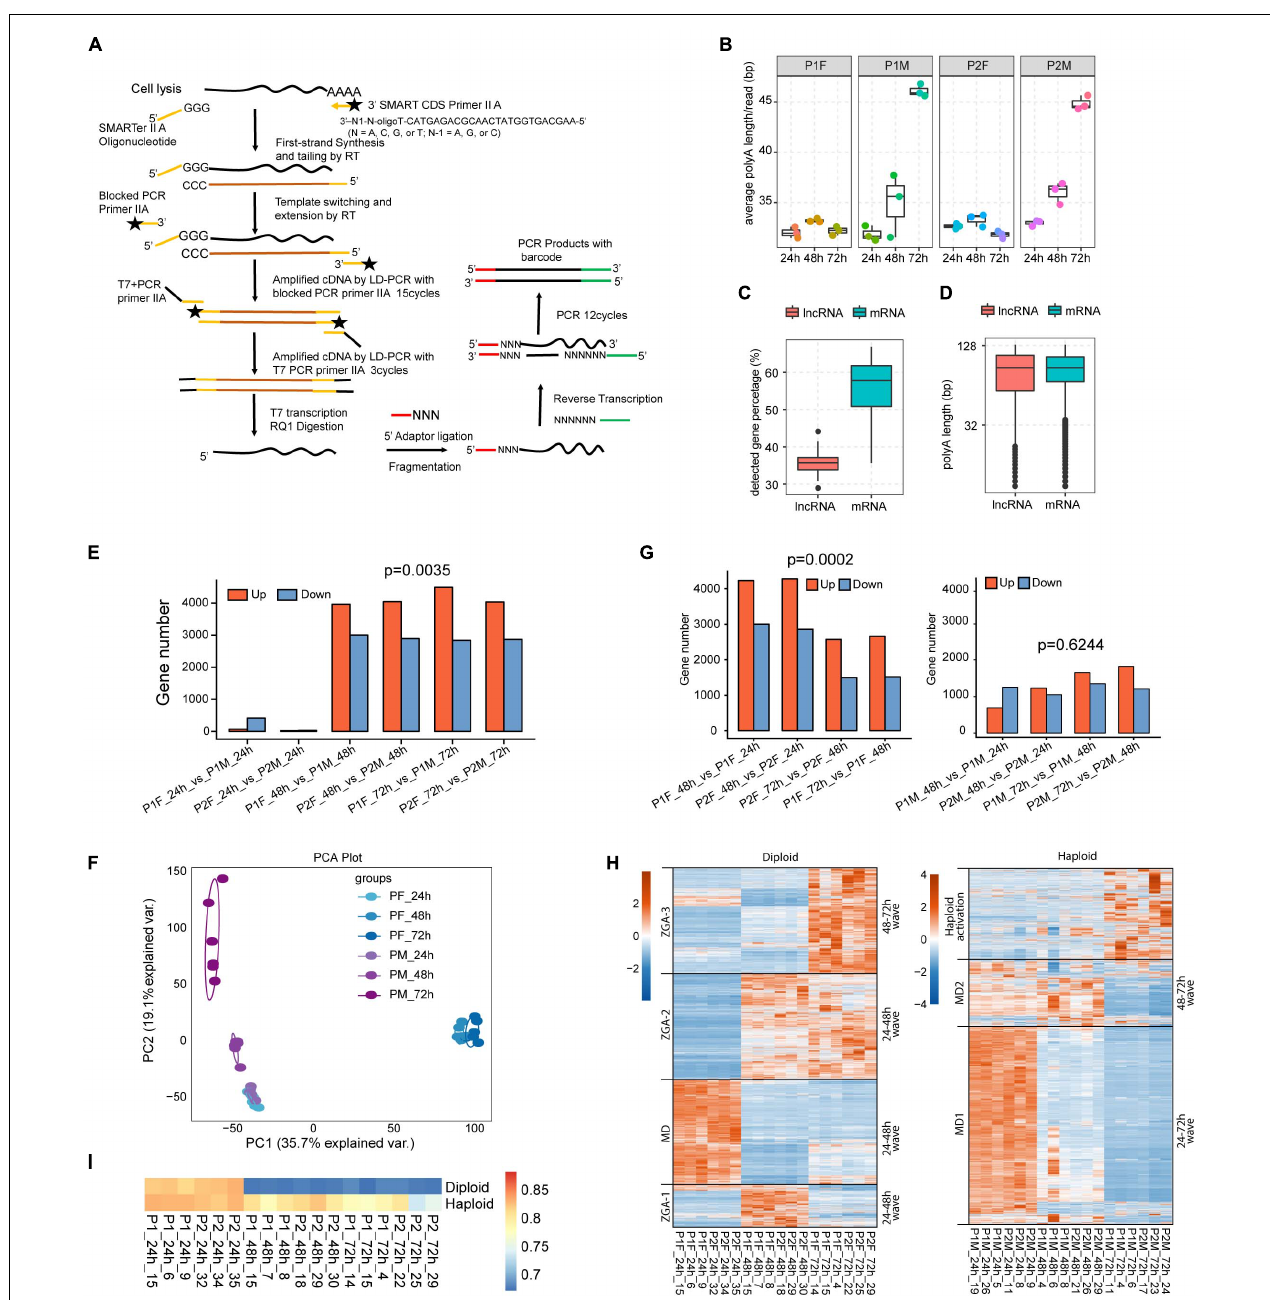
FIGURE 1 | The difference in the developmental transcription program activation between diploid female and haploid male embryos. (A) Schematic plot showing the workflow of single-embryonic library construction. (B) Box plot of average poly (A) length showing that the poly (A) length of male embryos increased during embryonic development ( p -value < 0.001, one way ANOVA test for both datasets), while that of female kept constant ( p -value > 0.01, one way ANOVA test for both datasets). (C) Box plot showing that the percentage of lncRNAs with poly (A) tails was lower than that of mRNAs ( p -value < 0.0001, t -test). (D) Box plot of the poly (A) length showing that there was no significant difference of average poly (A) length (middle line in box plot) between lncRNAs and mRNAs ( p -value > 0.05, t -test). (E) Barplot of DEGs between male and female embryos. More up-regulated DEGs were observed in female embryos after 24 h (up-regulated DEGs number vs. down-regulated DEGs number, p -value = 0.0035, t -test). (F) PCA analysis showing the divergent gene expression pattern between male and female embryos after 24 h. (G) Barplot of DEGs between adjacent time points for female (left) and male (right) embryos, respectively. More up-regulated DEGs were observed in female embryos during development (up-regulated DEGs number vs. down-regulated DEGs number, p -value = 0.0002, t -test). (H) Hierarchical clustering heatmap showing the expression waves of all DEGs detected in this study. Male and female samples were separated for the plotting. Expression waves were separated by black lines. The dendrogram was not shown. MD: maternal degradation. (I) The Pearson’s correlation coefficients (PCCs) was shown by heatmap for each of the single-embryonic samples with the published oocyte sample (Pires et al., 2016).